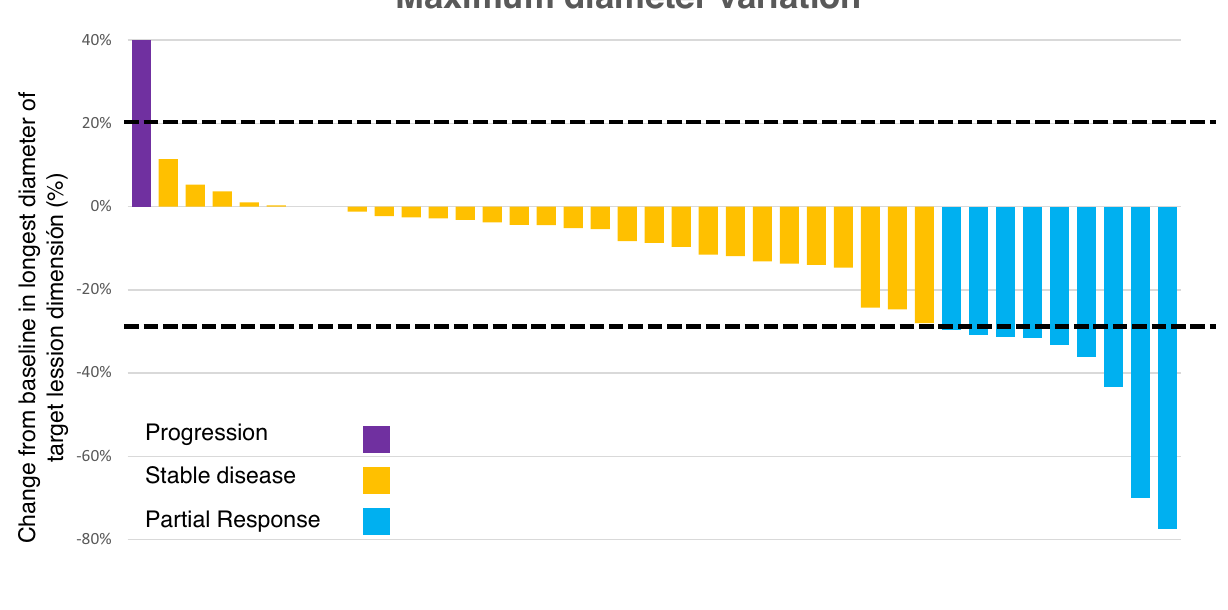
Fig. 2 | Water fall plot. Among the 39 evaluable patients with evaluable data, the OverallResponse Rate (ORR)byRECIST1.1was23%. Lower and upperdashed lines representthecut-offforprogressivedisease(anincreaseofatleast20%inthesum